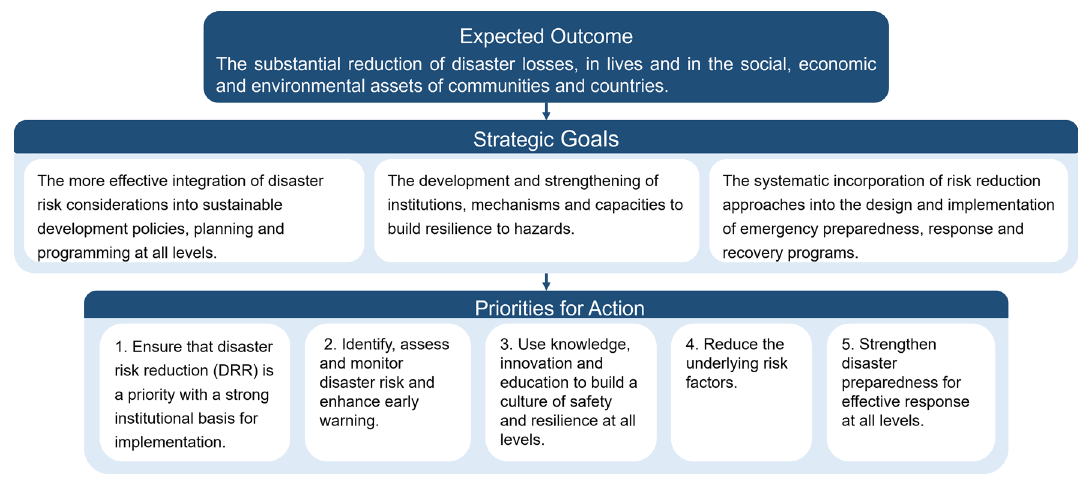
Fig. 2 The Hyogo Framework for Action 2005−2015: Expected outcome, strategic goals, and priorities for action (United Nations 2005)